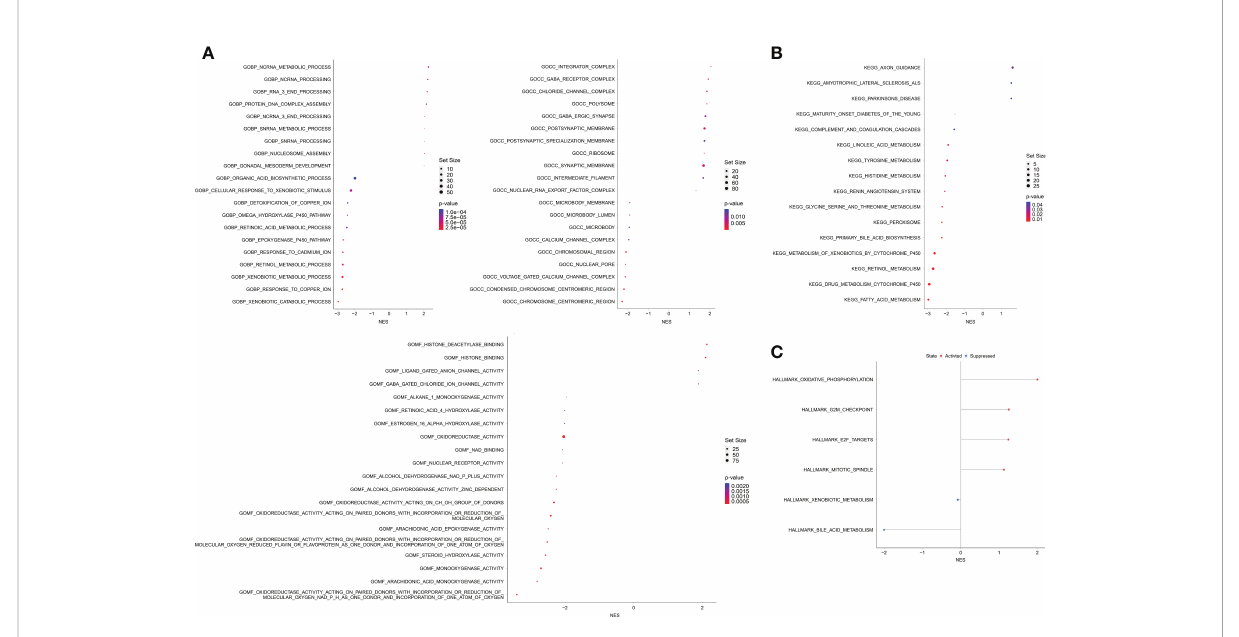
FIGURE 5 Biological enrichment analysis between high and low OAG score groups. (A) Gene ontology enrichment analysis. (B) Kyoto Encyclopedia of Genes and Genomes enrichment analysis. (C) Gene set enrichment analysis based on the Hallmark pathways. OAG, overweight/obesity- associated